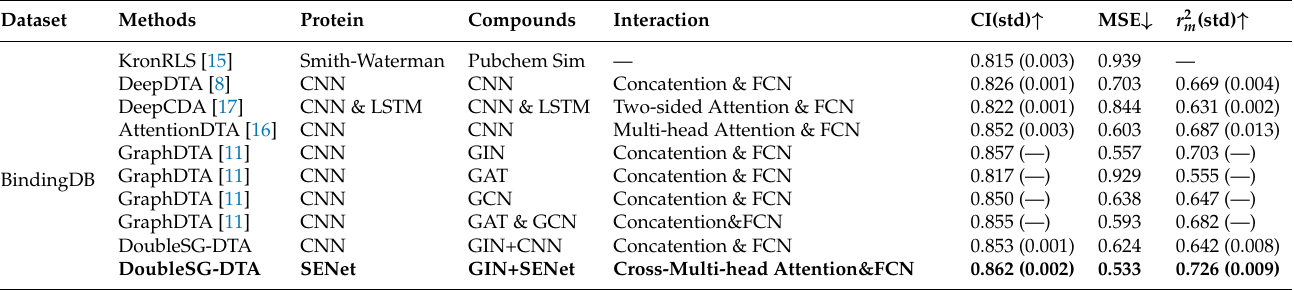
Table 5. Comparison of previous studies and the DoubleSG-DTA on the BindingDB